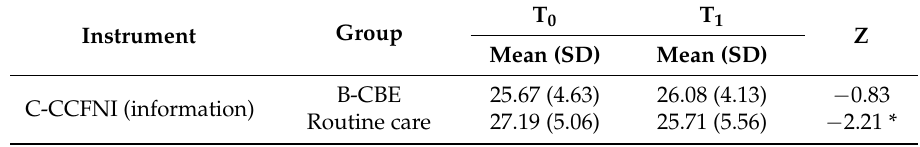
Table 4. Post hoc analysis in comparing the pre-post measurement on information satisfaction.